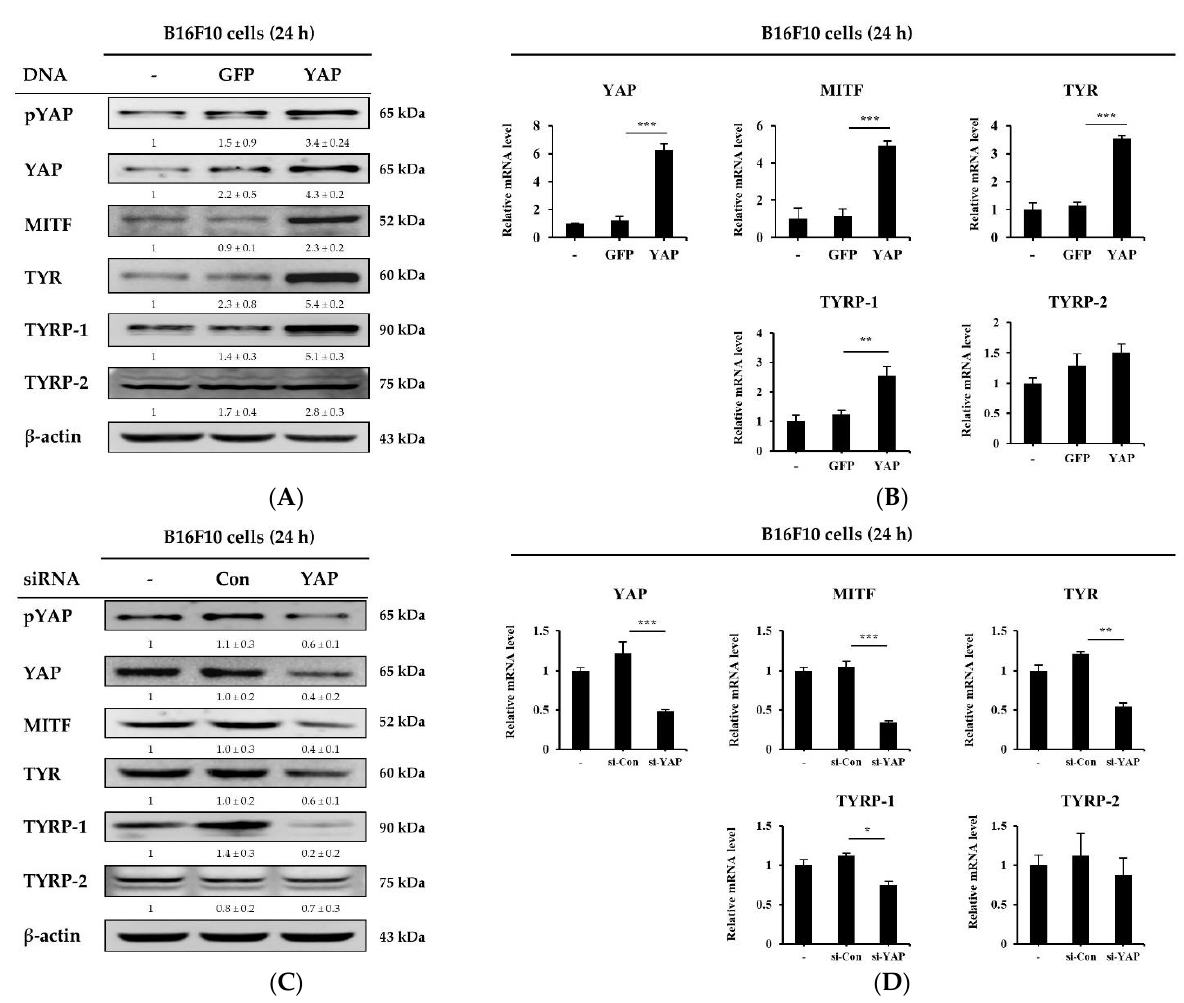
Figure 8. Melanogenesis-related molecules are mediated by YAP. ( A , B ) B16F10 cells were transfected with a plasmid overexpressing either GFP (a control) or YAP, and incubated for a further 24 h. ( A ) pYAP, YAP, MITF, TYR, and TYRP-1, 2 levels were evaluated by Western blotting. β -actin was used as a loading control. ( B ) YAP , MITF , TYR and TYRP-1, 2 expression levels were determined by qRT-PCR. ( C , D ) B16F10 cells were transfected with either control siRNA or YAP siRNA, and incubated for 24 h. ( C ) pYAP, YAP, MITF, TYR, TYRP-1, 2 and β -actin were determined by Western blotting, and ( D ) YAP , MITF , TYR and TYRP-1, 2 expression levels were analyzed by qRT-PCR. Data represent three independent experiments (means ± SD). * p < 0.05, ** p < 0.01, *** p < 0.001. Numerical values on the blots represent DU. The control was normalized to 1